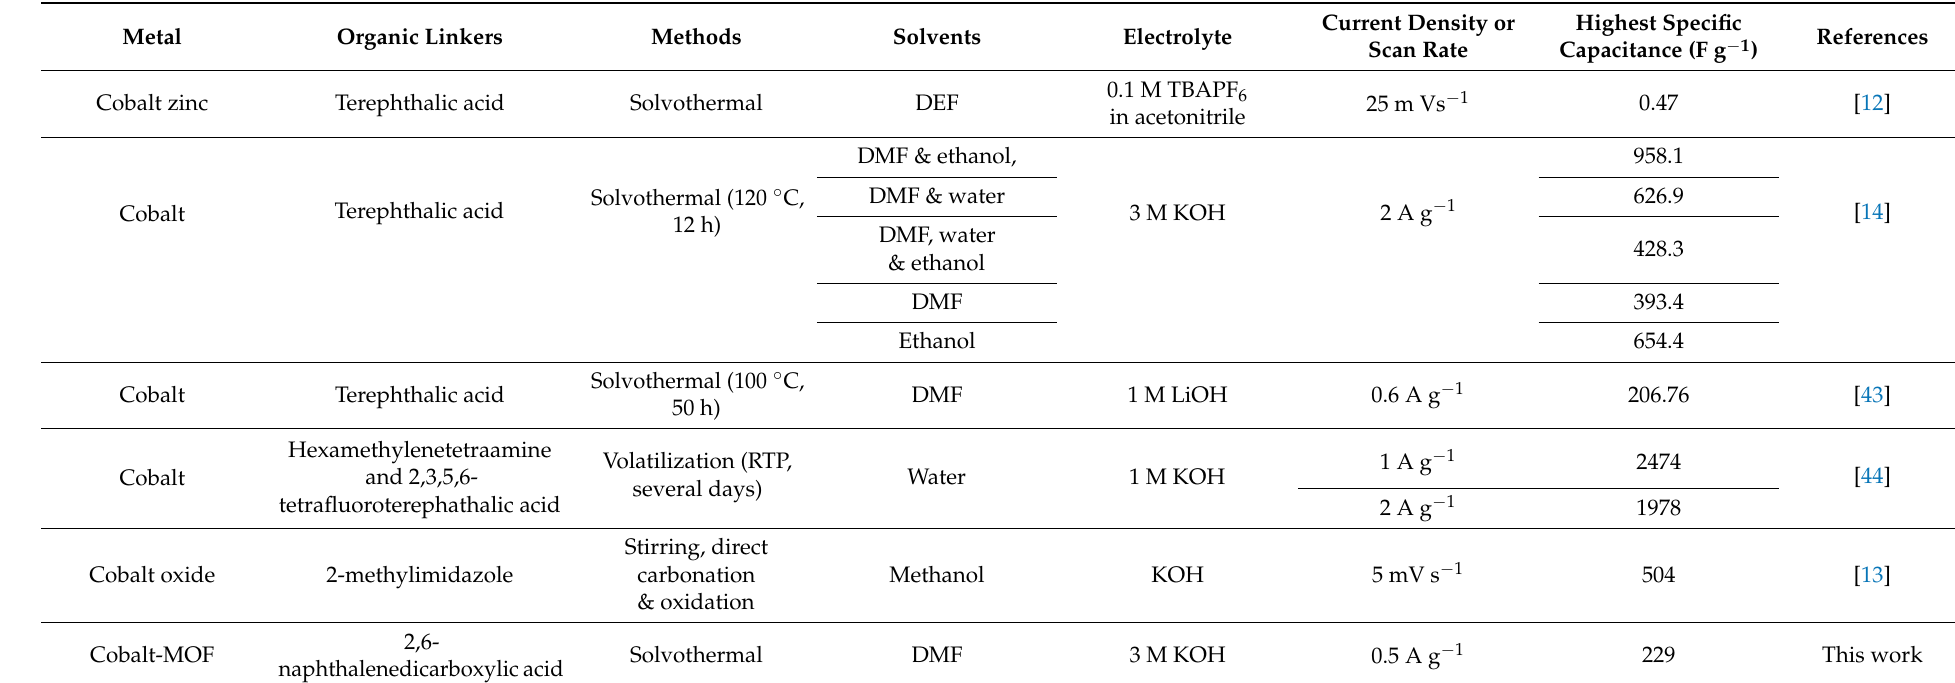
Table 3. The performance of the method used in this study in comparison with other methods in the